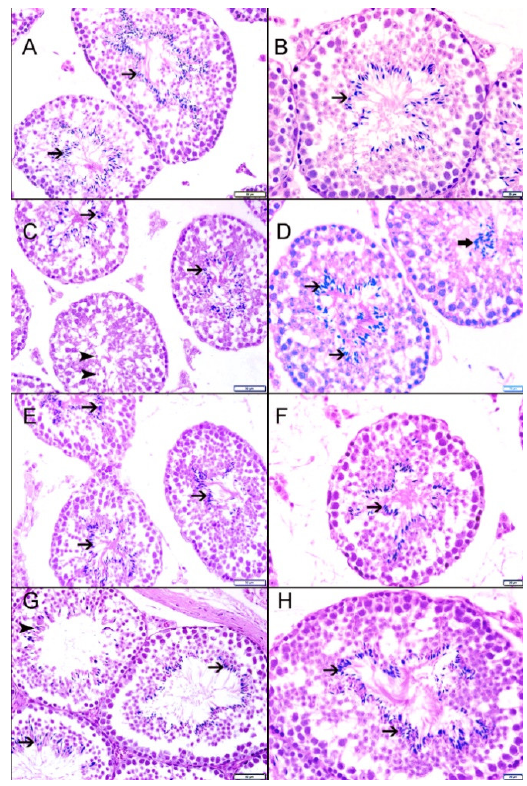
Figure 6. Representative histopathological micrographs, stained with hematoxylin and eosin (H&E), of testicular sections from mice exposed to air (AE), hookah smoke (HS), gum acacia (GA), and HS + GA groups. ( A , B ) Representative sections from testes of control group (AE) showing well-maintained spermatogenesis with spermatozoa (arrow) in seminiferous tubules. ( C ) Representative sections from testes of HS-treated group showing well-maintained spermatogenesis with spermatozoa (arrow) in seminiferous tubules; however, some of the tubules showed no spermatozoa but spermatids in seminiferous tubules (arrowhead). ( D ) Representative sections from testes of HS-treated group showing well-maintained spermatogenesis with spermatozoa (arrow) in seminiferous tubules; however, some of the tubules showed disorganized spermatogenesis with accumulation of spermatozoa in the lumen of seminiferous tubules. ( E , F ) Representative sections from testes of AE + GA-treated group showing well-maintained spermatogenesis with spermatozoa (arrow) in seminiferous tubules. ( G , H ) Representative sections from testes of HS + GA-treated group showing well-maintained spermatogenesis with spermatozoa (arrow) in seminiferous tubules. Some tubules show fewer spermatozoa (arrowhead). Scale bar in images A, C, E, and G = 50 μm. Scale bar in images B, D, F, and H = 20 μm.